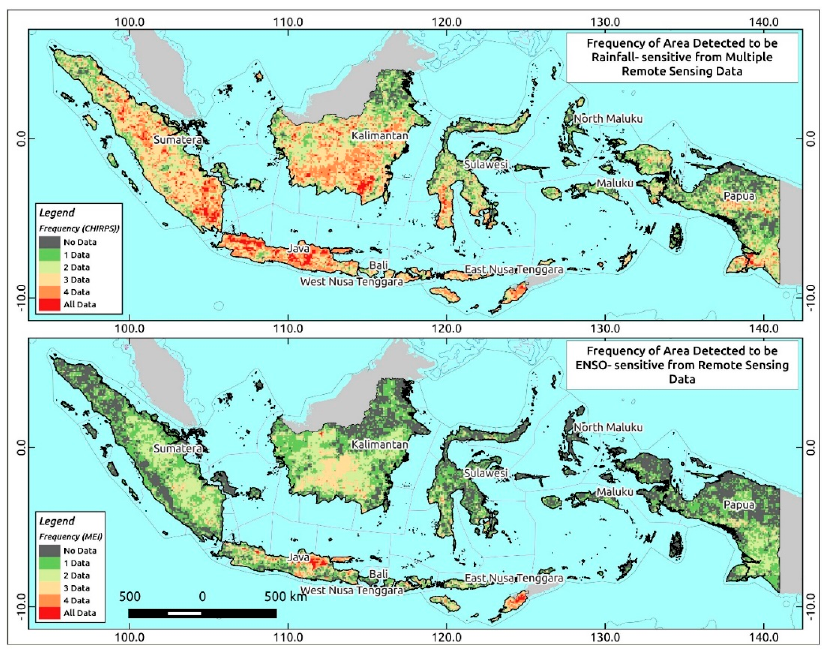
Figure 6. Frequency of datasets indicating an area as sensitive to rainfall ( top ) and ENSO ( bottom ) from multi-sensor data shows different distributions with higher spatial agreement in the rainfall-sensitive areas. Table 2. Areas of each land cover identified as sensitive to one or more RS proxies.